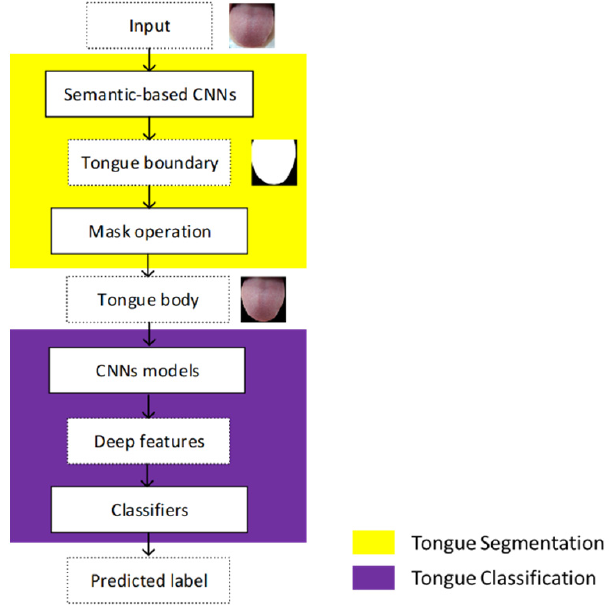
Figure 4. The overall framework of the proposed algorithm.